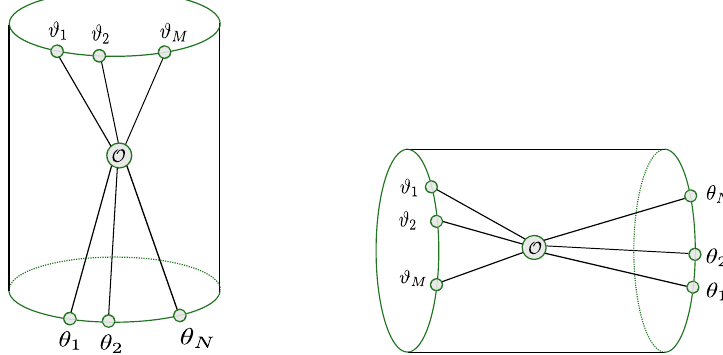
Figure 2 . On the left: graphical representation of a finite volume form factor with incoming state and outgoing state . Particles’ trajectories are schematically drawn as solid ϑ 1 , . . . , ϑ M θ 1 , . . . , θ N (cid:30) | (cid:30) | lines and the operator is represented as a circle. On the right: the same form factor is represented O after double Wick rotation in the thermal channel, i.e. when the Euclidean time is finite and space is